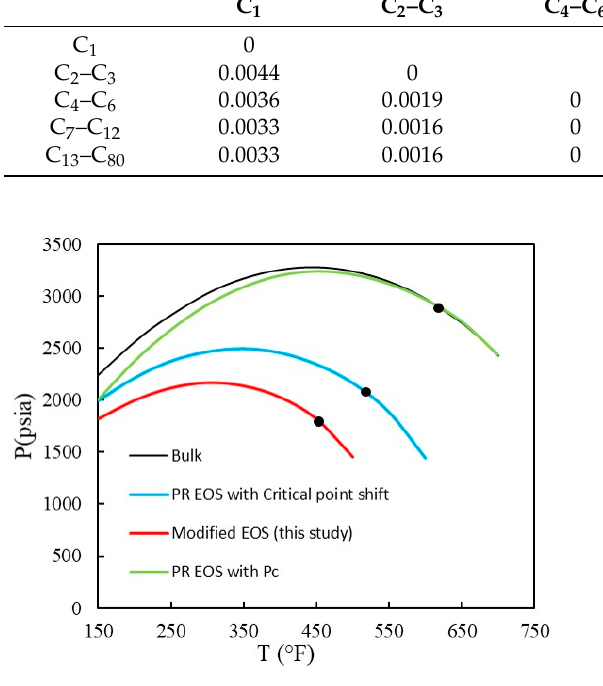
Figure 9. Comparison of P-T phase diagrams of shale oil at the bulk condition with those using methods of capillary pressure, critical shift, and modified EOS in this study. Black points represent critical points.